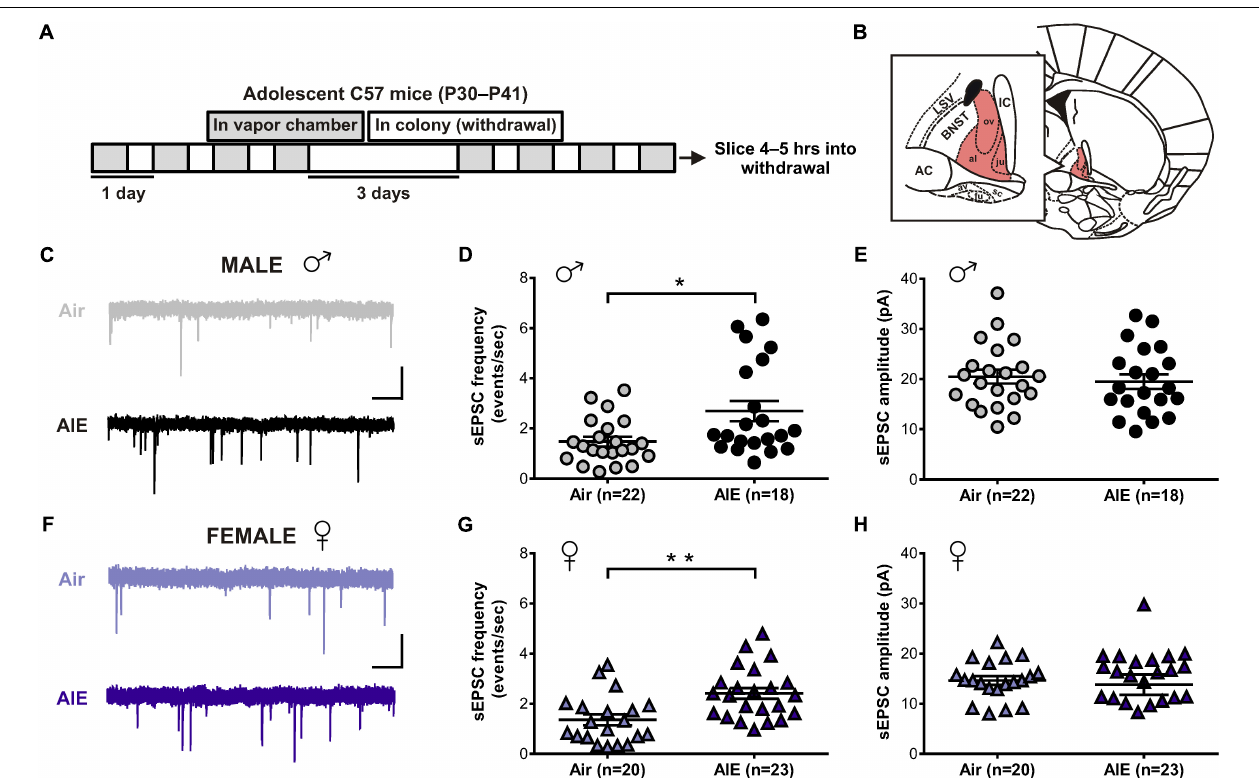
FIGURE 1 | Spontaneous EPSCs in the dorsolateral BNST (dlBNST) following acute withdrawal from adolescent chronic intermittent ethanol treatment (AIE) in the male and female mice. (A) Schedule of ethanol and water vapor exposure; mice were placed in a chamber filled with volatilized ethanol (AIE) or volatilized water (Air) for four 16-h blocks of exposure, separated by four 8-h periods of withdrawal. (B) Illustration of a coronal brain section with the dlBNST shown in red. AC, anterior commissure; IC, Internal capsule; LSV, lateral septal nucleus; note, lowercase abbreviations refer to subdivisions of the BNST. Representative sEPSC traces from control (top, gray) and intermittent ethanol-exposed (bottom, black) male (C) and female (F) mice; vertical scale bar = 15 pA, horizontal scale bar = 500 ms. Quantification of sEPSC frequency (D,G) and amplitude (E,H) in dlBNST neurons of male (circles) and female (triangles) mice. Lines show mean ( ± SEM), symbols indicate significant differences determined by unpaired t -tests; ∗ p < 0.05, ∗∗ p < 0.01.